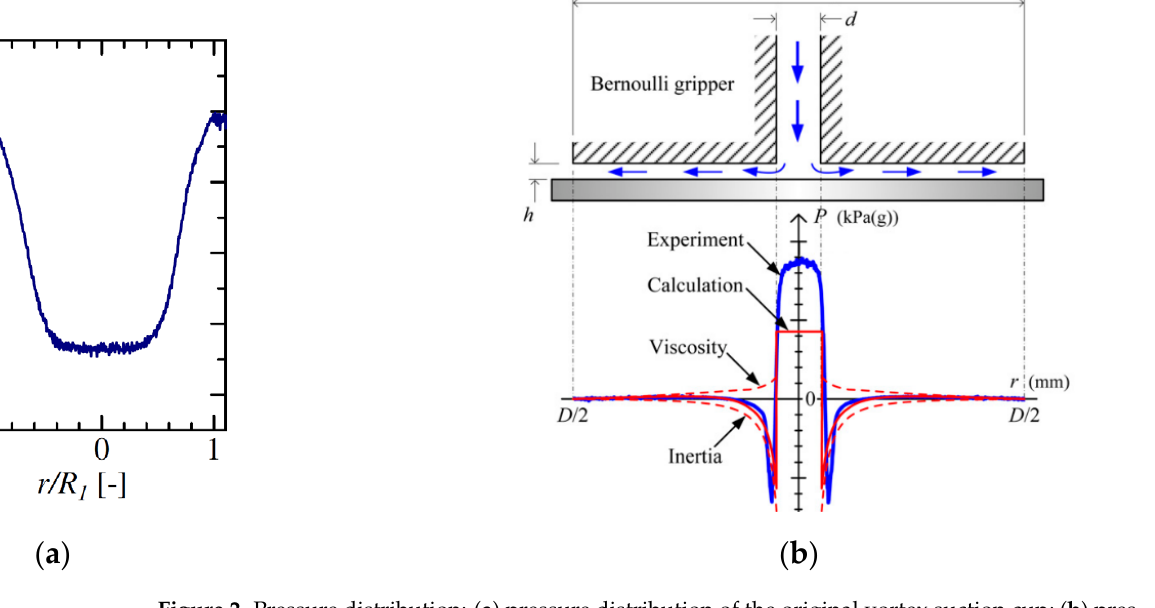
Figure 2. Pressure distribution: ( a ) pressure distribution of the original vortex suction cup; ( b ) pres- sure distribution of the Bernoulli suction cup/gripper.